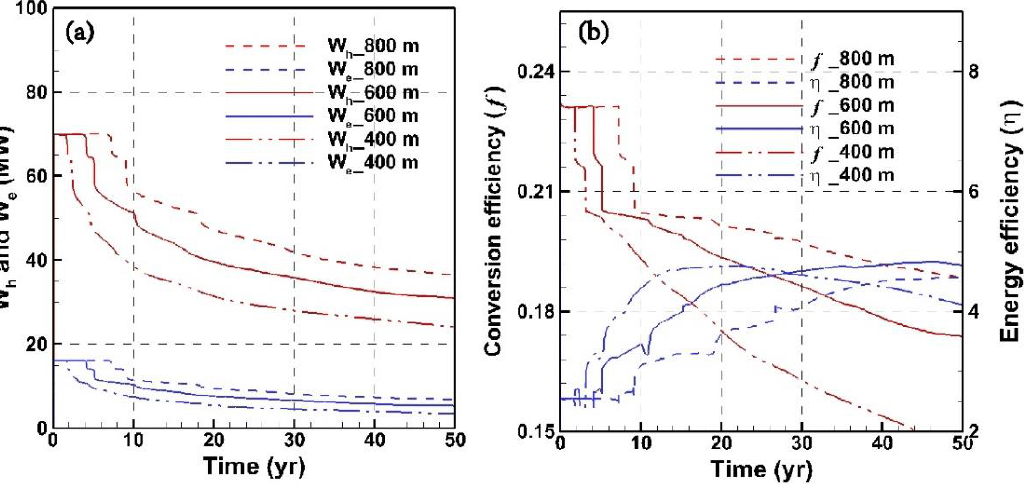
Figure 10. The evolution of net heat flow ( W h ), power generation ( W e ) ( a ), and conversion efficiency and energy efficiency ( b ) with different well spacing.